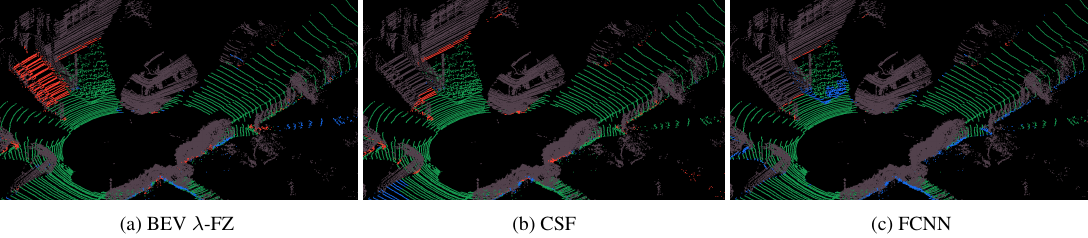
Figure 9. Qualitative results. Green points are true positives, red ones are false positives, blue false negatives and gray ones are true negatives. BEV λ -FZ includes stairs nearby the road as ground. The λ used is larger than the step. FCNN misses some nearby ground points.